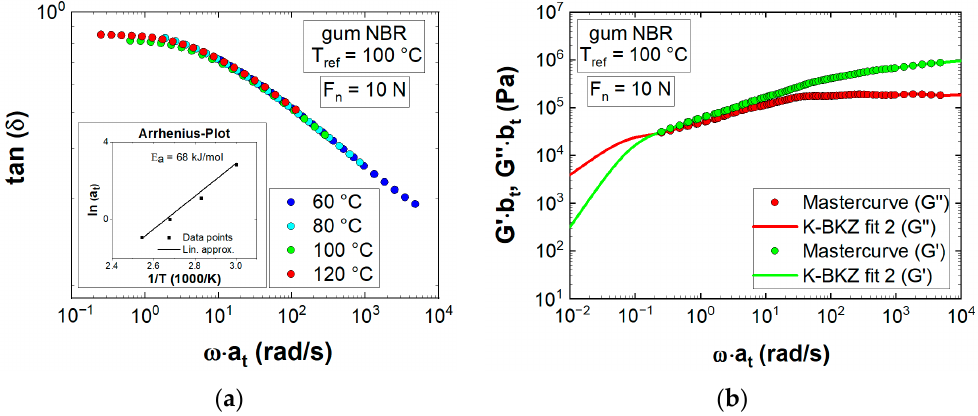
Figure A3. ( a ) Time-temperature superposition of the phase angle 𝛿 and corresponding Arrhenius plot; ( b ) K-BKZ model predictions of storage G (cid:4593) and loss G (cid:4593)(cid:4593) moduli compared to experimental data at the reference temperature T ref ; K-BKZ fit 2 represents fitted LVE data measured at F n = 10 N.